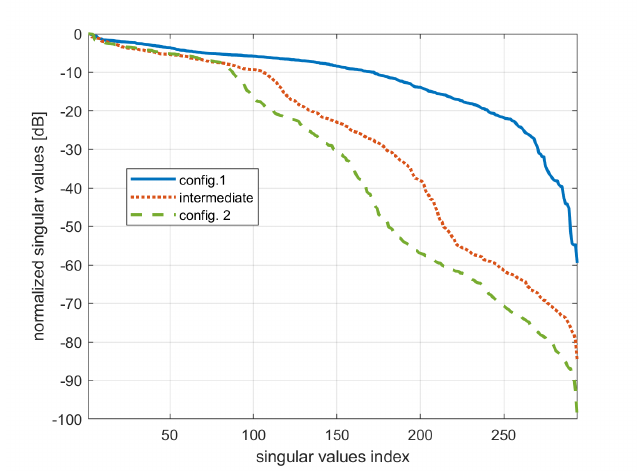
Figure 3. Singular values of G for different measurement configurations. Intermediate configuration uses same D as config. 1 and maximum frequency as config. 2.